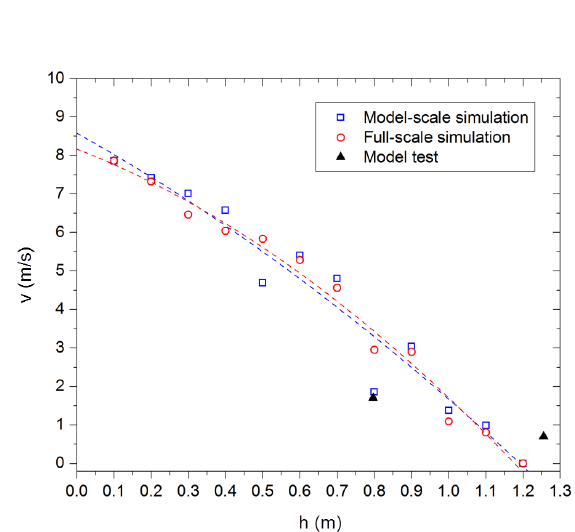
Figure 26: h − ν curve obtained when the vessel is running astern (the scaled model-scale sim- ulation results and the full-scale simulation results with scaled ice and ship parameters)